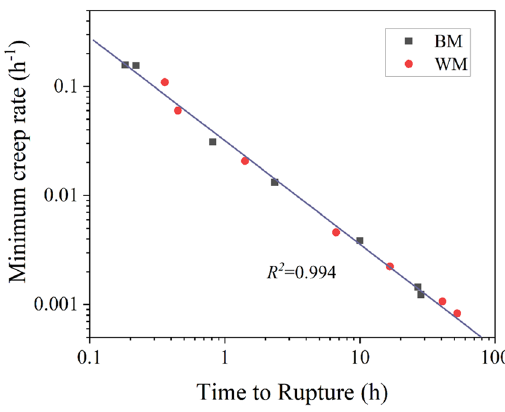
Figure 9: The relationship between the minimum creep rate and the creep